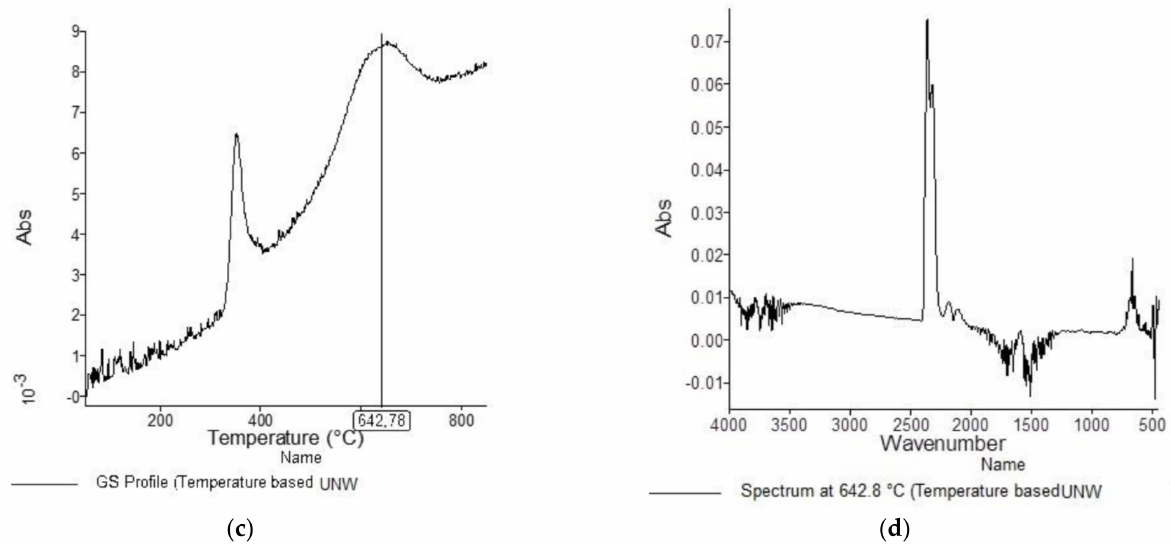
Figure 2. TG–IR analysis of cellulosic material treated with Proban ® method during thermooxidative decomposition: ( a ) and ( c ) intensity profile FT–IR spectrum of gas evolved, ( b ) FT–IR spectrum of gas evolved at 351.0 ◦ C, ( d ) FT–IR spectrum of gas evolved at 642.8 ◦ C.